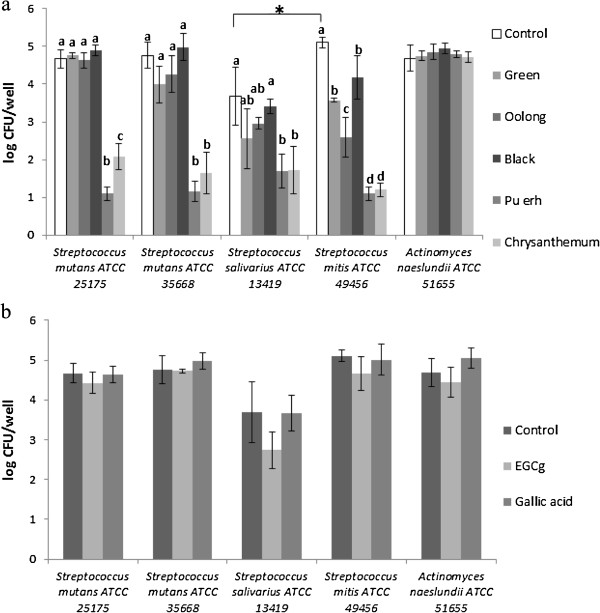
Effects of extracts and compounds on oral bacterial attachment. Effect of tea extracts (a) and EGCg and gallic acid (b) on oral bacterial attachment to the HGF-1 gingival cell line (log CFU/cm2, n = 3). Values labeled with the same letter are not significantly different (p > 0.05) among the treatments within a strain. Tukey’s comparisons were conducted separately for each strain. The * symbol indicates that the attachment of Streptococcus salivarius was significantly different from that of Streptococcus mitis (p < 0.05).